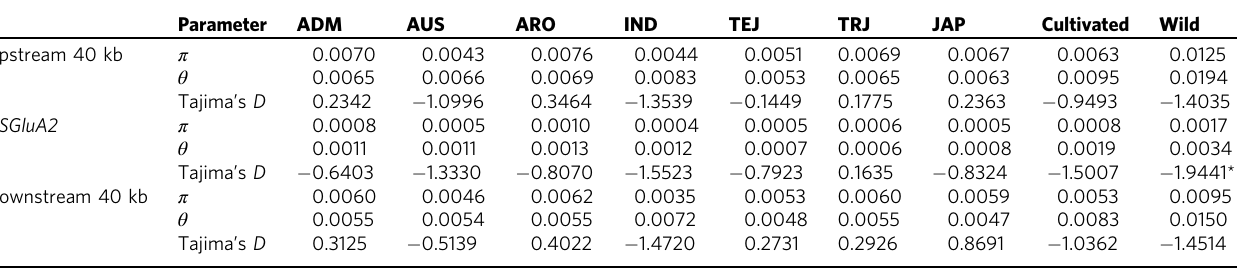
Single asterisk (*) indicates signi fi cance level at P <0.05 tested by computing 1000 coalescent simulations